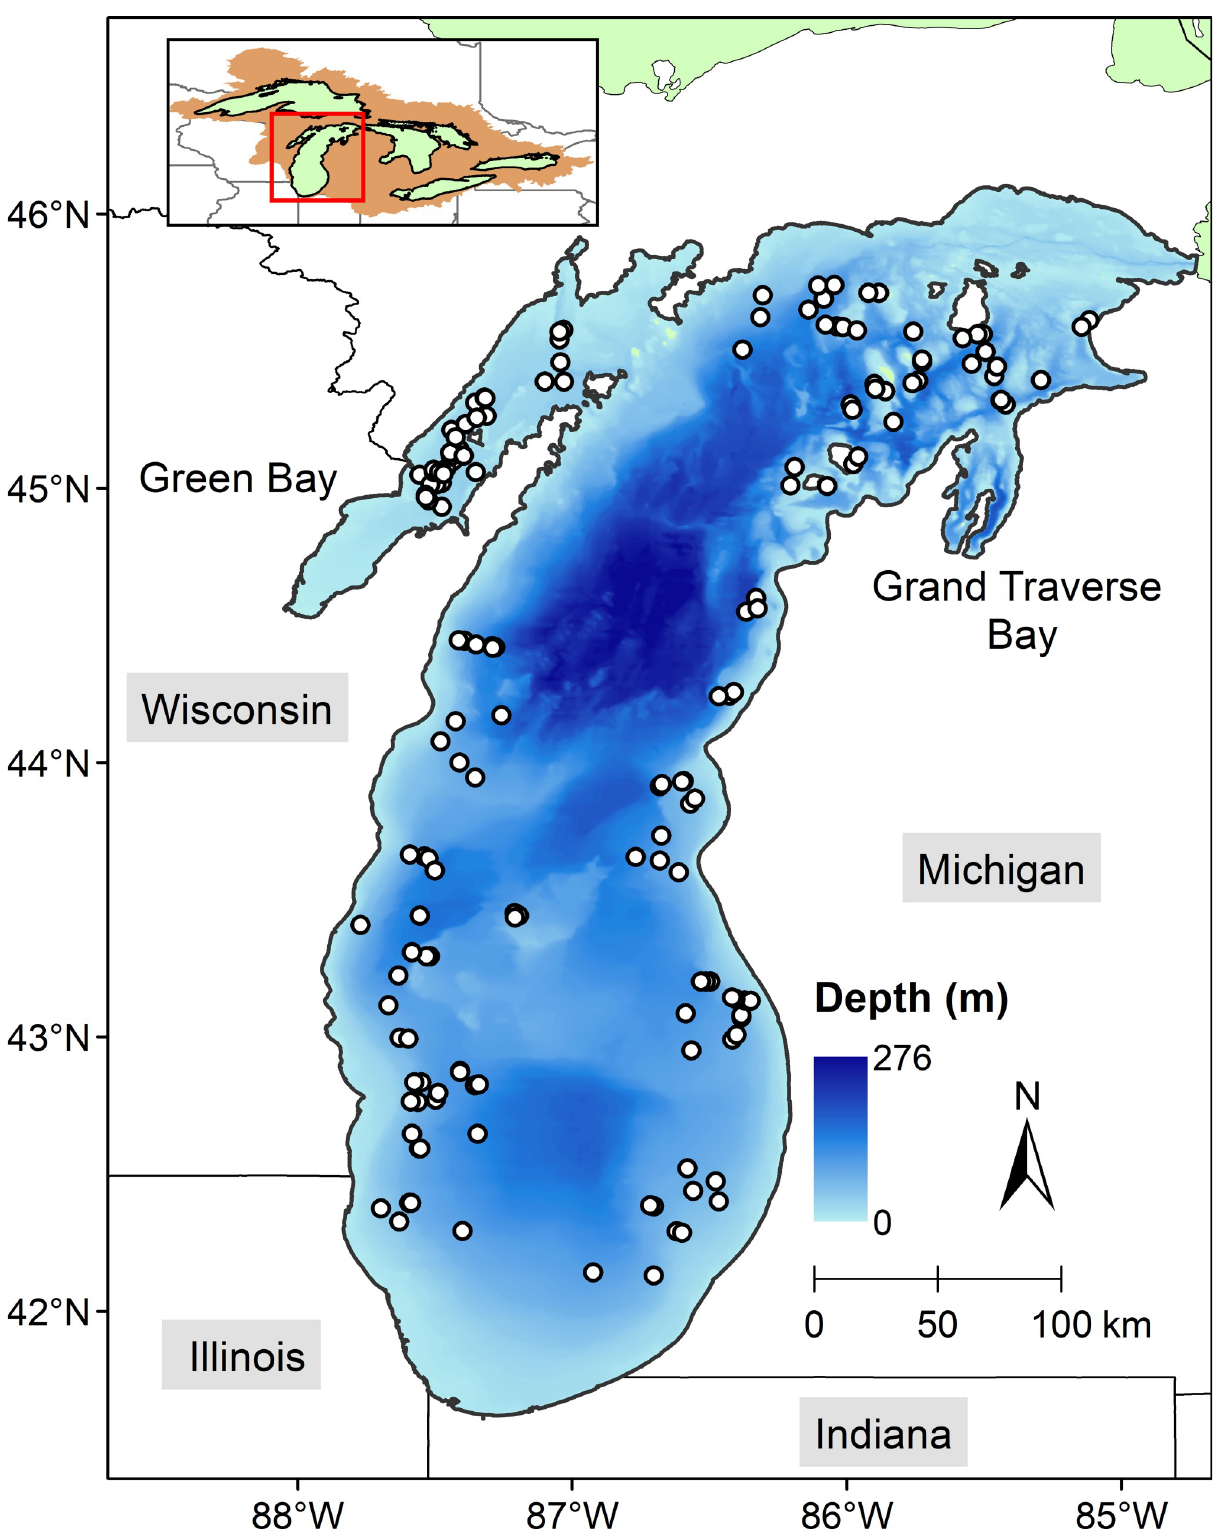
Fig 1. Lake Michigan map. The shaded area in the locator map depicts the Great Lakes watershed. White circles are the Fulmar sampling stations pooled across all seasons in 1930–1932. The map was generated by using a geographic information system (GIS) software ArcGIS version 10.4